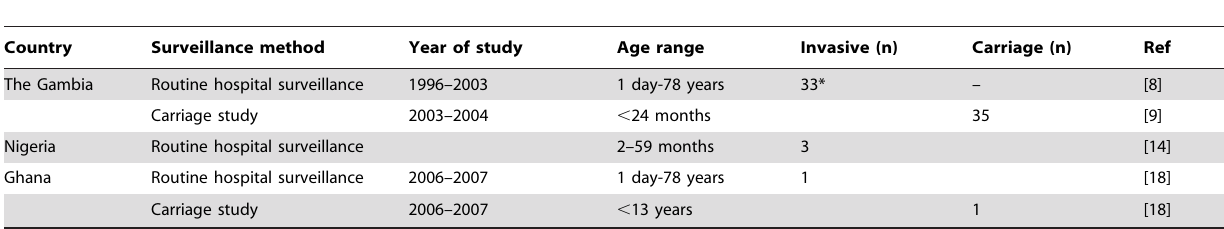
Table 1. Provenance of S. pneumoniae isolates used in this study.